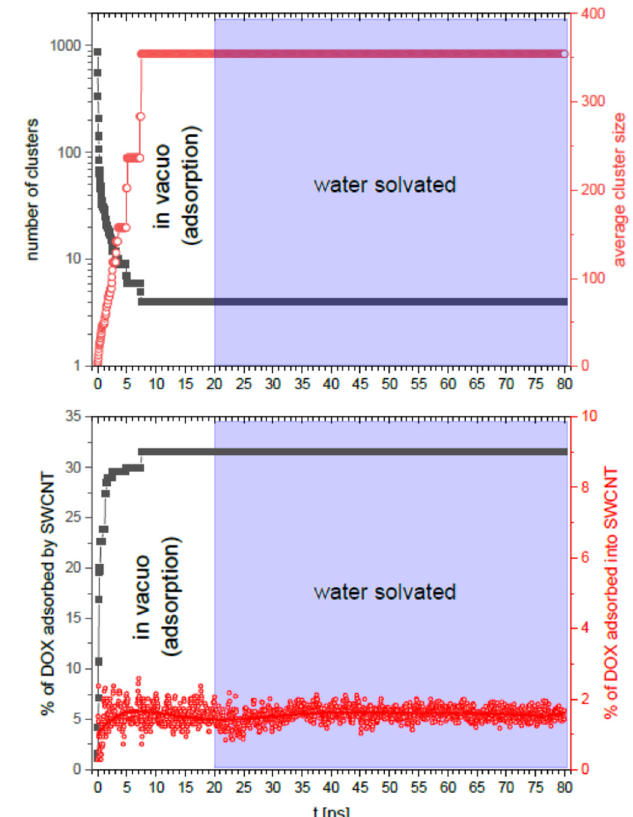
Figure 11. Selected physical quantities as a function of time, t , from molecular dynamics simulation of SWCNTs + DOX system during adsorption in vacuo (from t = 0 to t = 20 ns), and subsequent simulation of the system in solution with water (from t = 20 ns to t = 80 ns): ( a ) number of aggregates (grey squares) and average aggregate size (red circles); ( b ) total percentage of DOX molecules adsorbed by SWCNTs (grey squares) and percentage of DOX molecules adsorbed inside SWCNTs (red circles).